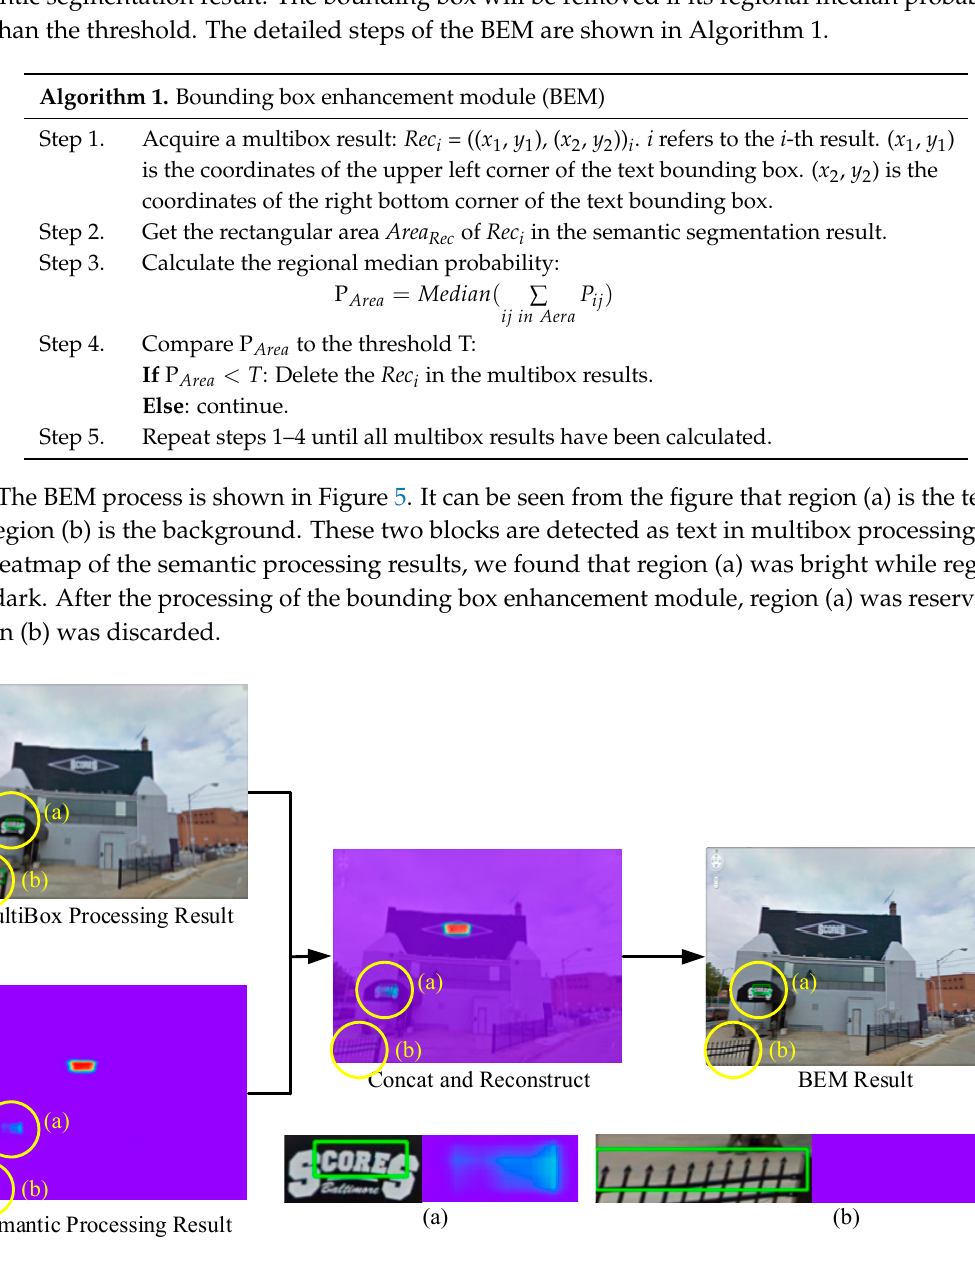
Figure 5. Flow chart of the BEM.